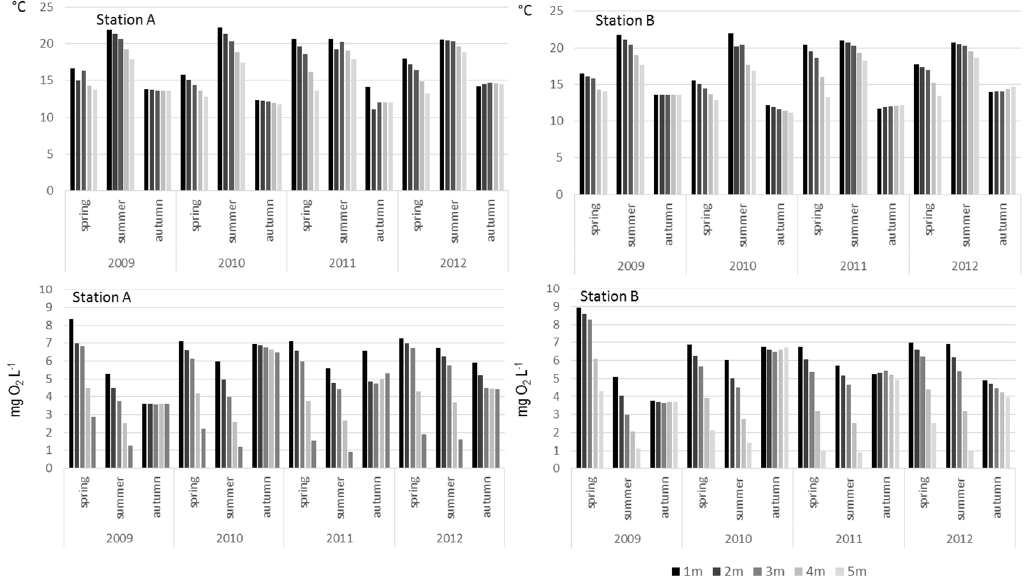
Figure 3. Changes of water temperature and oxygen concentration in vertical profile (1–5 m) of G łę bokie Lake.